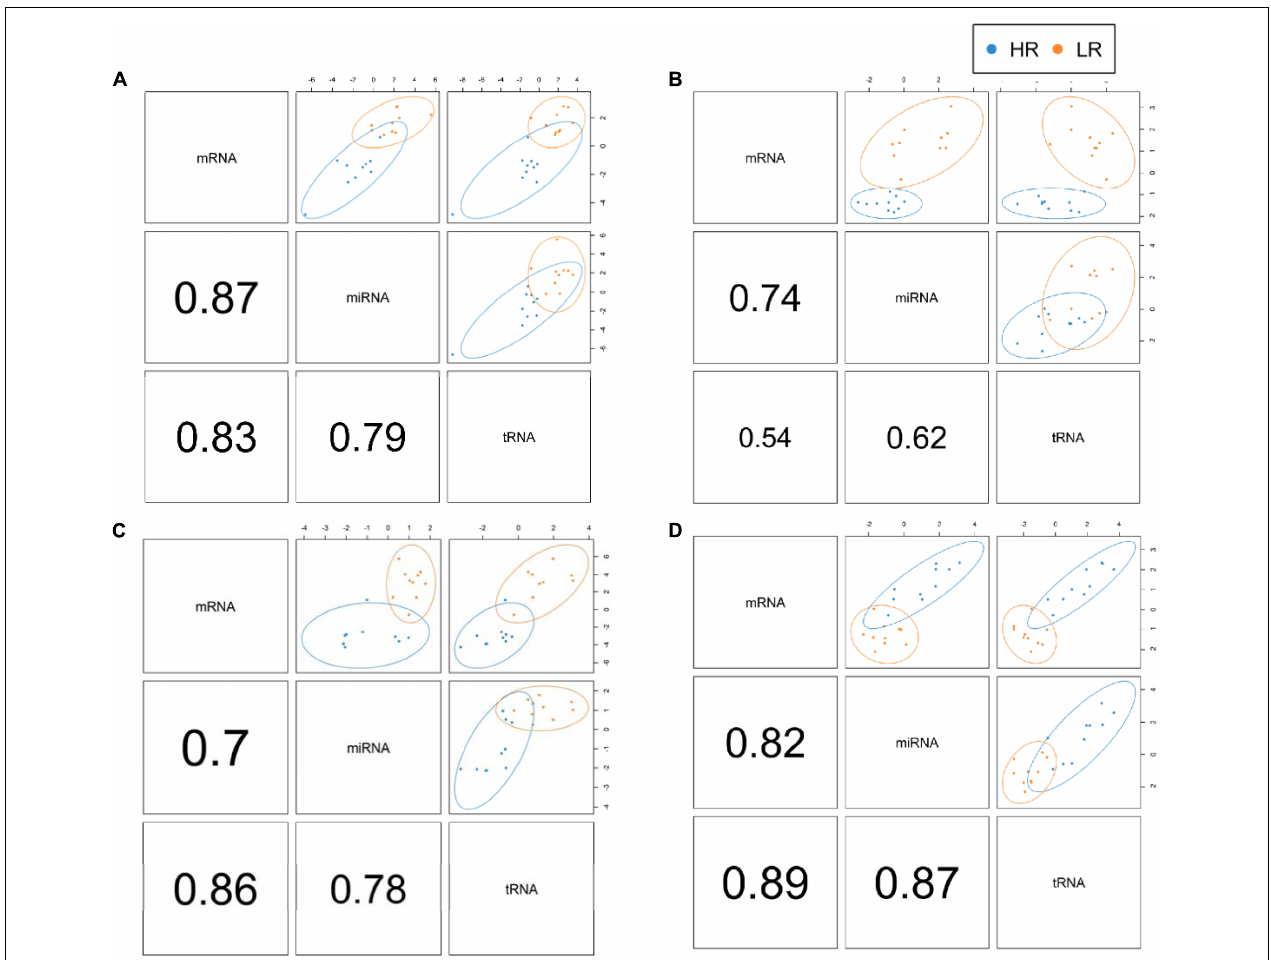
FIGURE 1 | DIABLO plots of the adrenal gland (A) , amygdala (B) , hippocampus (C) and hypothalamus (D) showing individual correlation strengths between the different RNA pairs. Red color indicates low-reactive (LR) group and blue depicts high-reactive (HR) group association.